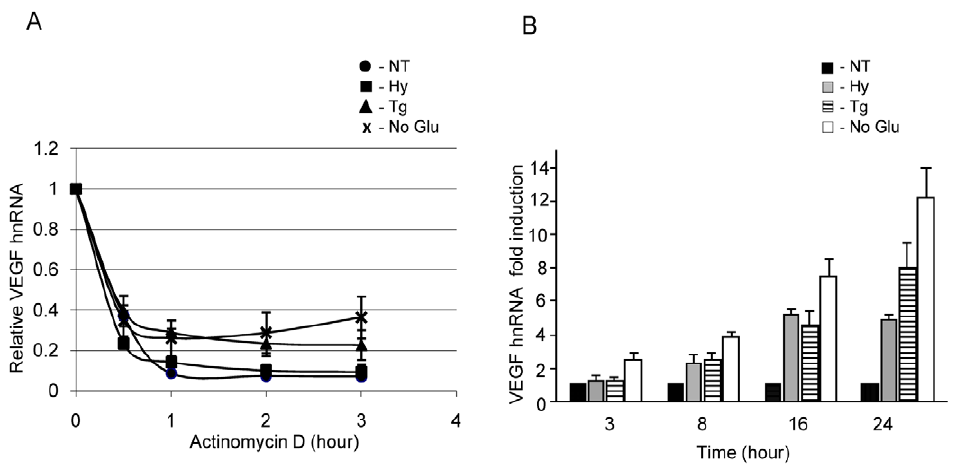
Figure 3. UPR activation increases VEGF transcription rate. ( A ) C6 cells were pre-treated with normal culture conditions (NT-circle), 1% O 2 (Hy- square), thapsigargin (Tg-triangle), or no glucose media (No Glu-cross) for 6 hours as indicated. Actinomycin D (5 m g/ml) was added to block further transcription. At the indicated times, total RNA was extracted and subjected to qRT-PCR to determine the kinetics of the disappearance of VEGF hnRNA in control and stressed cells. ( B ) C6 cells were untreated (NT-black), treated with 1% O 2 (Hy-grey), thapsigargin (Tg-striped) or no glucose media (No Glu-white) for the indicated times. Total RNA was extracted, and VEGF hnRNA was quantitated by qRT-PCR. Experiments were performed in triplicate (values are mean 6 SD).